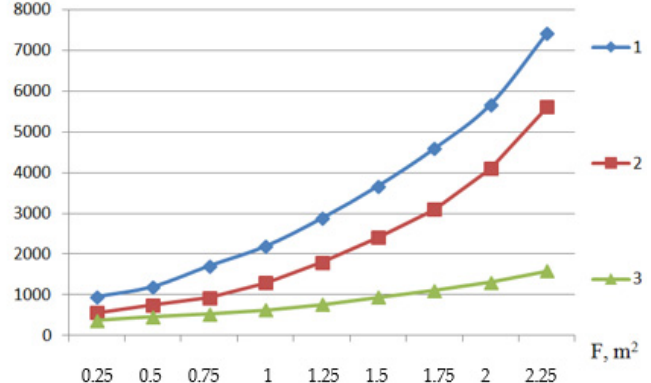
Figure 2. Dependence of energy E, (W) consumption on the cross-sectional area F, (m 2 ) to create a fluidized bed and mechanical shaking when freezing raspberries; 1—fluidized bed at V = 3.9 (m/s), 2—fluidized bed at V = 2.7 (m/s), 3—mechanical shaking.